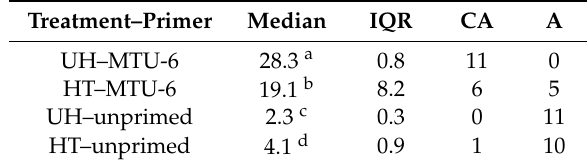
Table 2. Shear bond strength (MPa) and failure modes after testing.